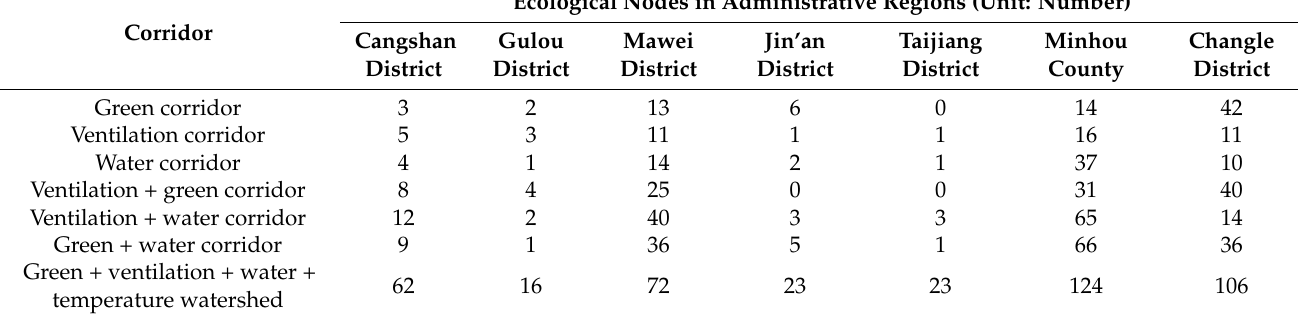
Table 2. Corridors overlayed: ecological node distribution statistics.